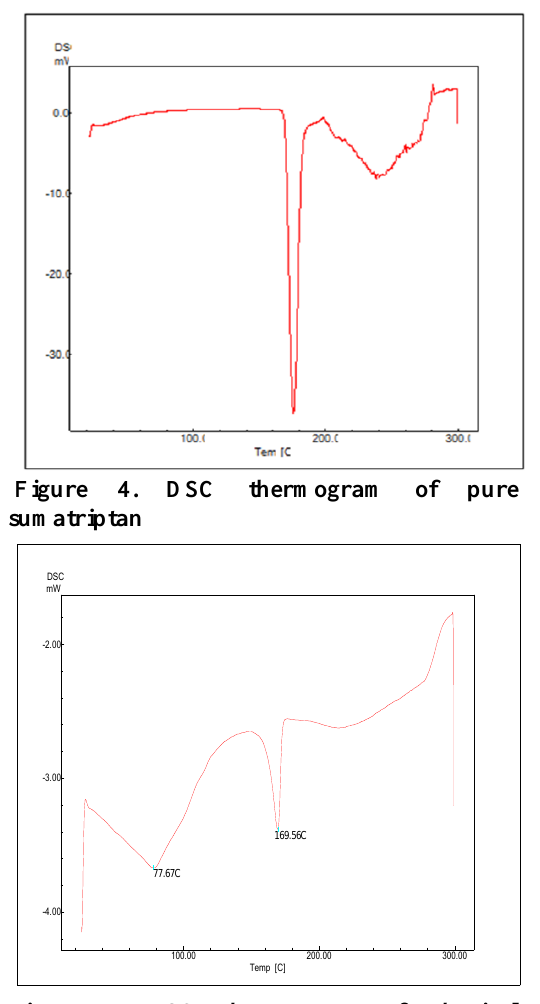
Figure 5. DSC thermogram of physical mixture of sumatriptan core tablet